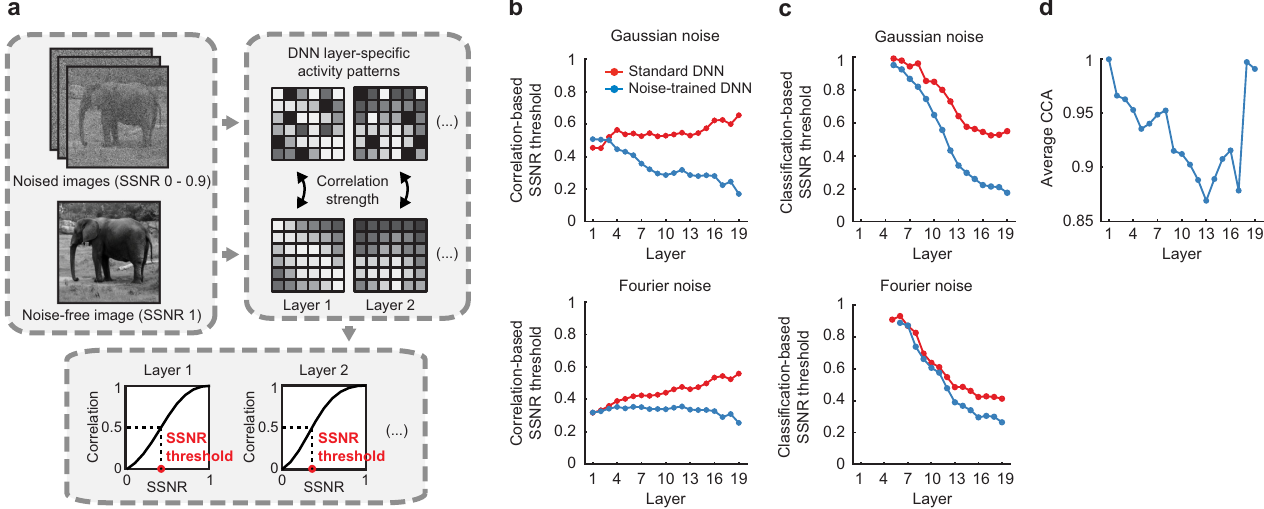
Fig 6. Layer-specific network changes caused by noise training. (a) Depiction of method used for layer-specific noise susceptibility analysis. (b) Correlation- based SSNR thresholds for pretrained (red) and noise-trained (blue) versions of VGG-19 plotted by layer for objects shown in pixelated Gaussian noise or Fourier phase-scrambled noise. Layers 1 to 16, convolutional layers after rectification; layers 17 and 18, fully connected layers after rectification; layer 19, softmax output layer. Higher SSNR thresholds indicate greater susceptibility to noise. (c) Classification-based SSNR thresholds plotted by layer for pretrained and noise-trained networks. Multiclass SVMs were used to predict object category from layer-specific activity patterns. (d) Similarity of feature representations for pretrained and noise-trained versions of VGG-19, calculated using CCA. Data are available at https://osf.io/bxr2v/. CCA, canonical correlation analysis; DNN, deep neural network; SSNR, signal-to-signal-plus-noise ratio; SVM, support vector